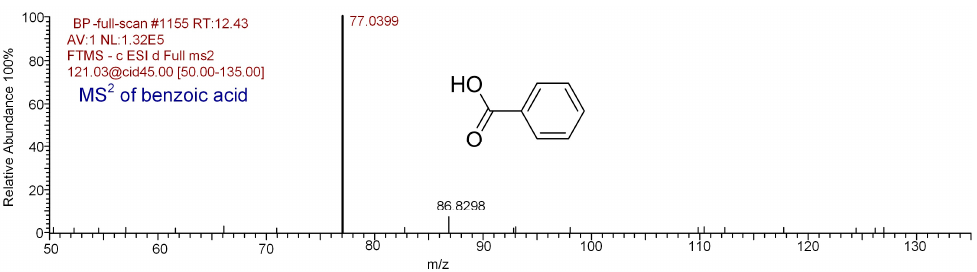
Figure A5. MS 2 spectra of benzoic acid by HRMS.